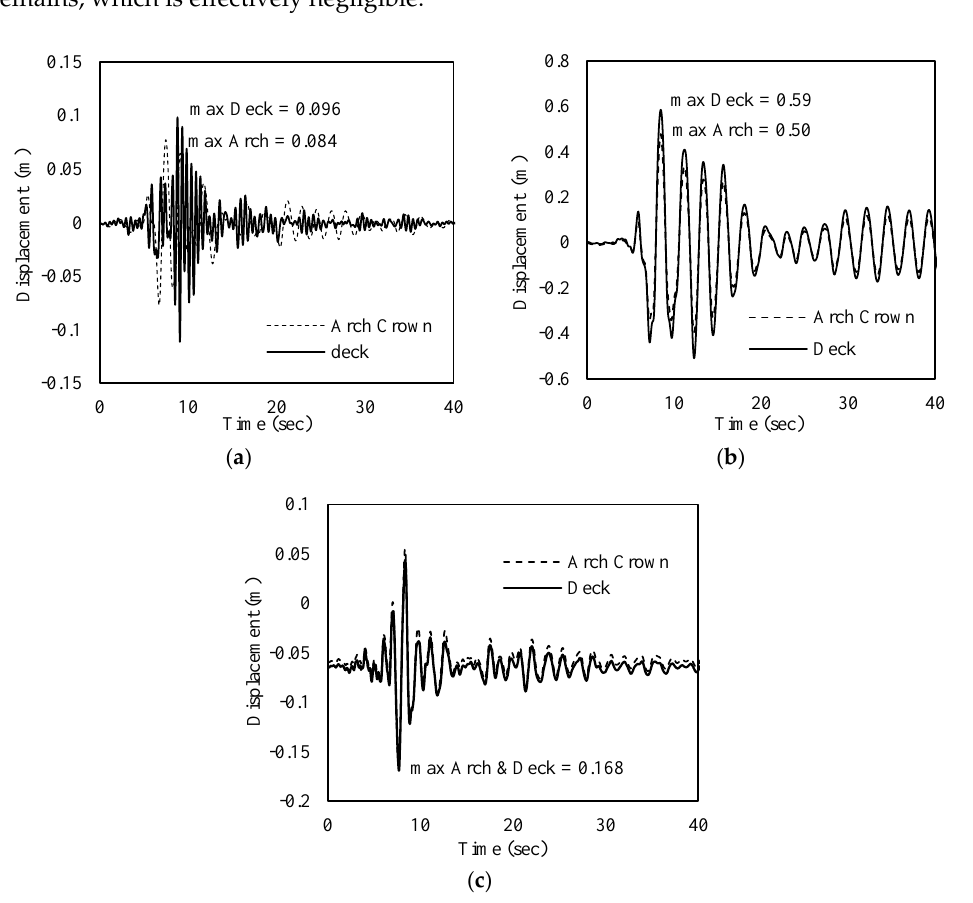
Table 5. Maximum displacement values at deck and arch crown for far-field earthquakes.